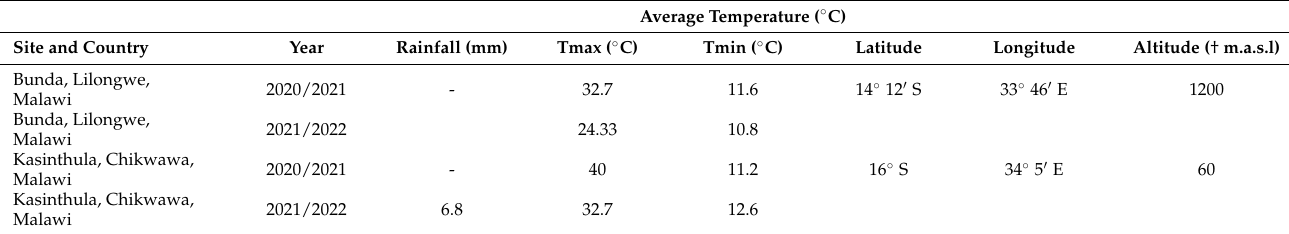
Table 1. Description of the study sites.